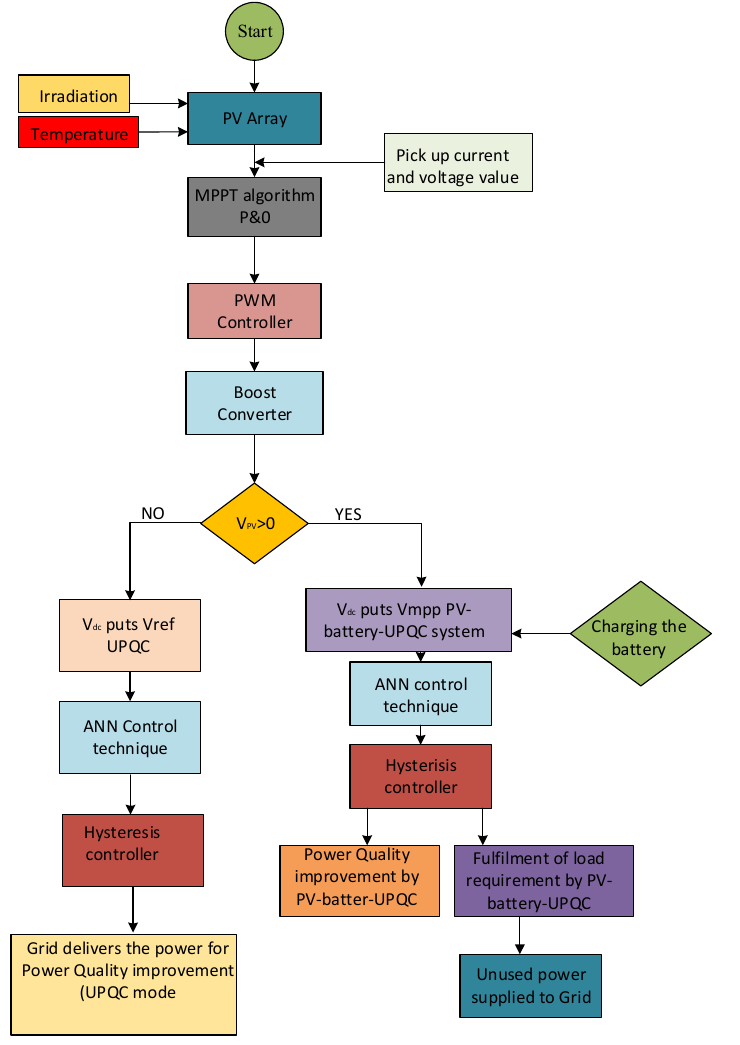
Figure 2. Maximum Power Point tracking algorithm.